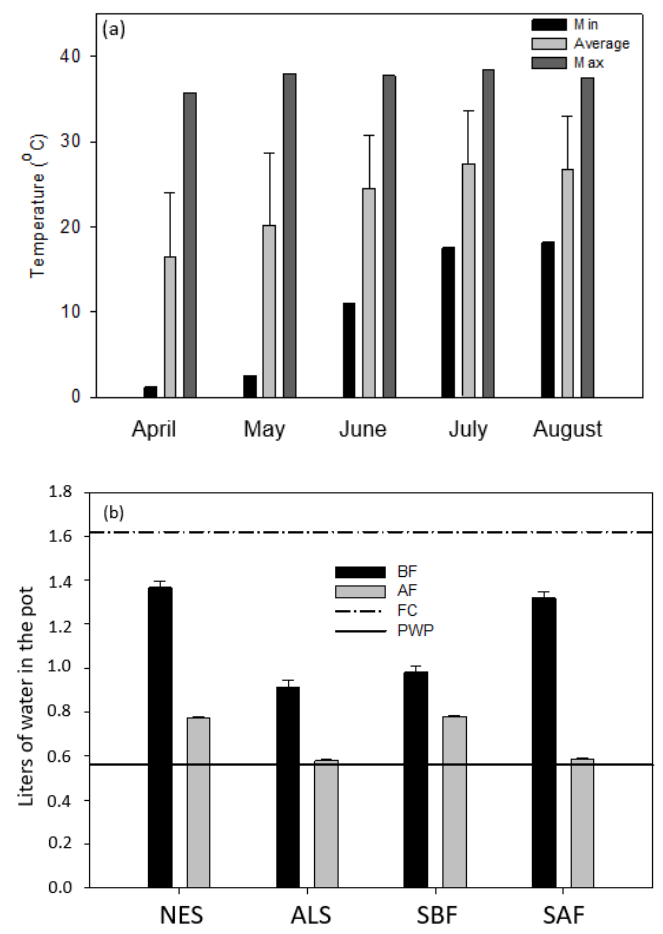
Figure 2. ( a ) Minimum, maximum, and average temperature inside the rain-out shelter from April 2020 until August 2020. ( b ) Hourly average of liters of water per pot in each treatment before flowering (black, BF) and after flowering (gray, AF). Field capacity (FC) is represented by the dash-dot line and permanent wilting point is represented by the solid line. Plant available water is the difference between the volume of water in the pot and the permanent wilting point. Treatments were (1) never stressed (NES), (2) always stressed (ALS), (3) stressed before flowering (SBF), and (4) stressed after flowering (SAF). The standard deviation is represented by error bars.